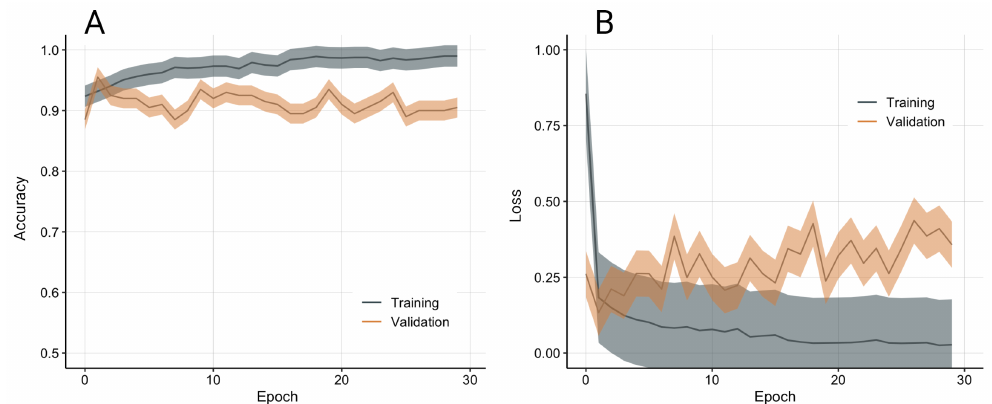
Figure 10. Model accuracy ( A ) and loss ( B ) from 10-fold stratified cross-validation. Data presented as average and standard